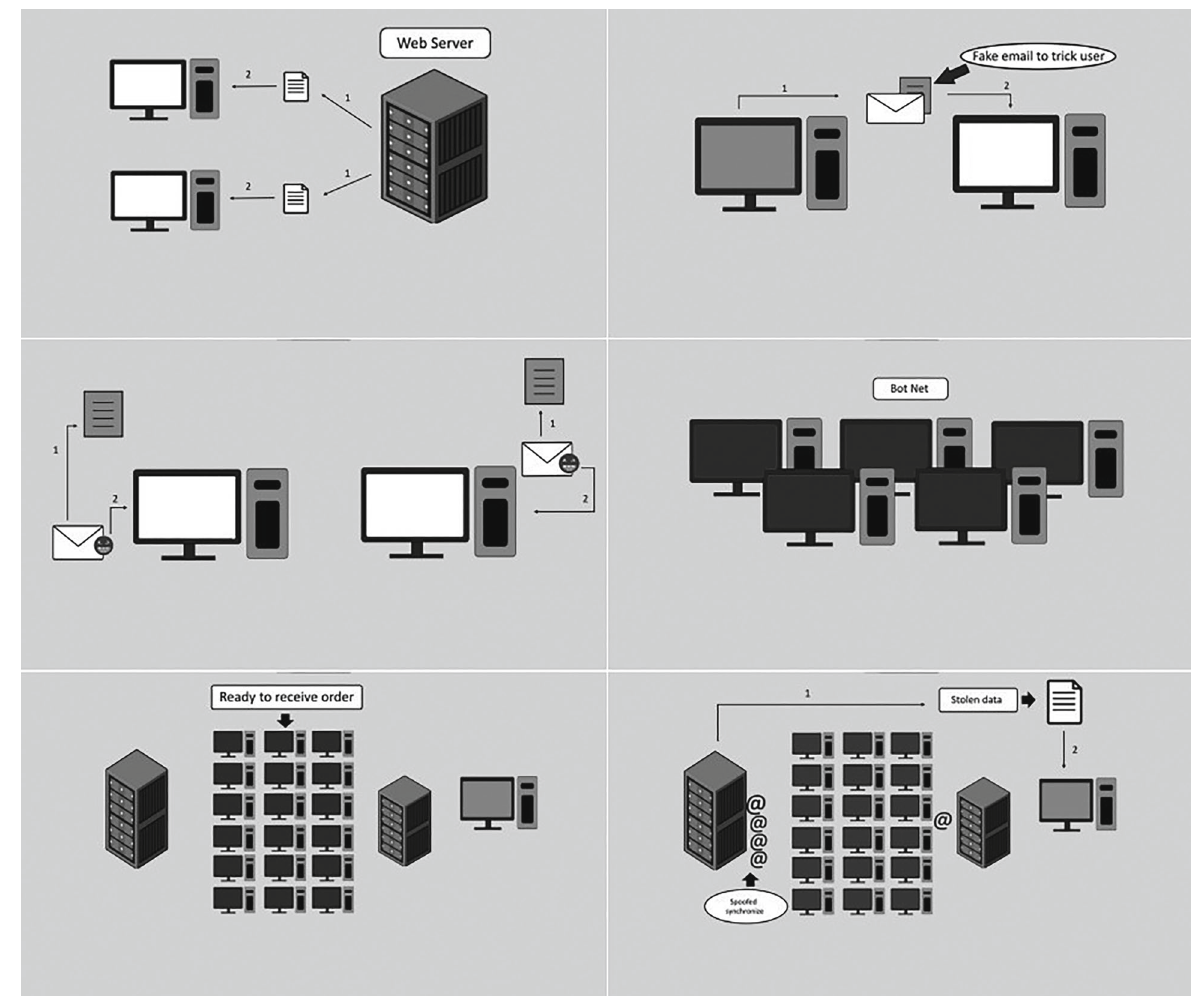
Figure 3: Sample multimedia learning visuals using achromatic grayscale color